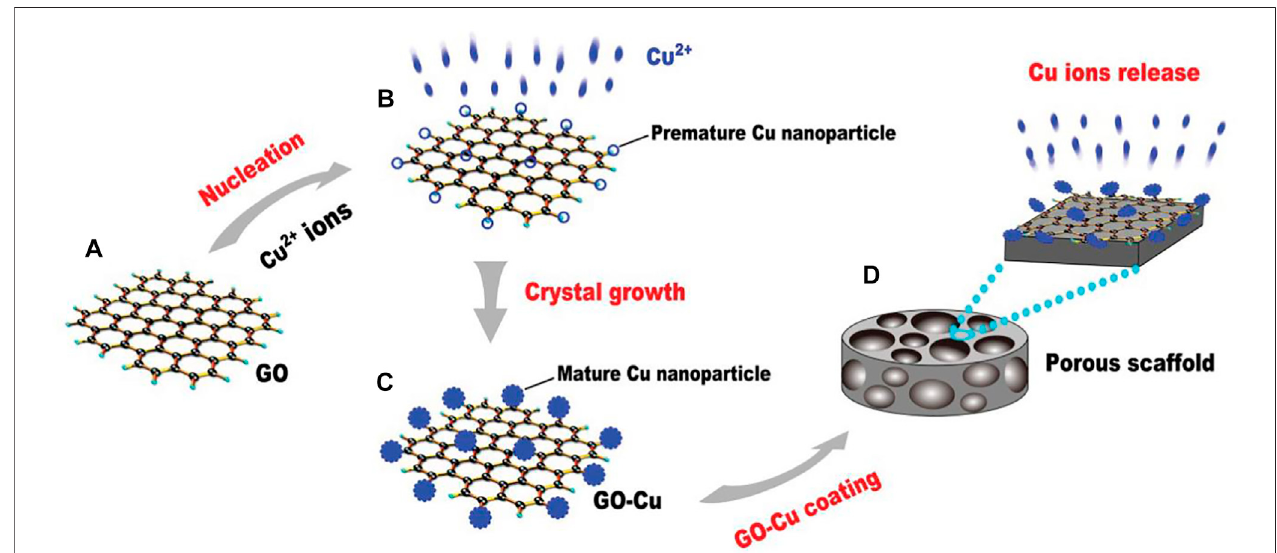
FIGURE7| Schematic ofthe experimental protocol for thefabricationofGO-Cu-coated CPC scaffolds. (A) The pattern ofGO. (B) Premature Cu nanoparticles on GO fi lm. (C) MaturenanoparticlesonGO fi lm. (D) GO-CucoatedporousCPCscaffold.ReproducedfromZhangetal.(2016)withpermissionfromCopyright2016Wiley.